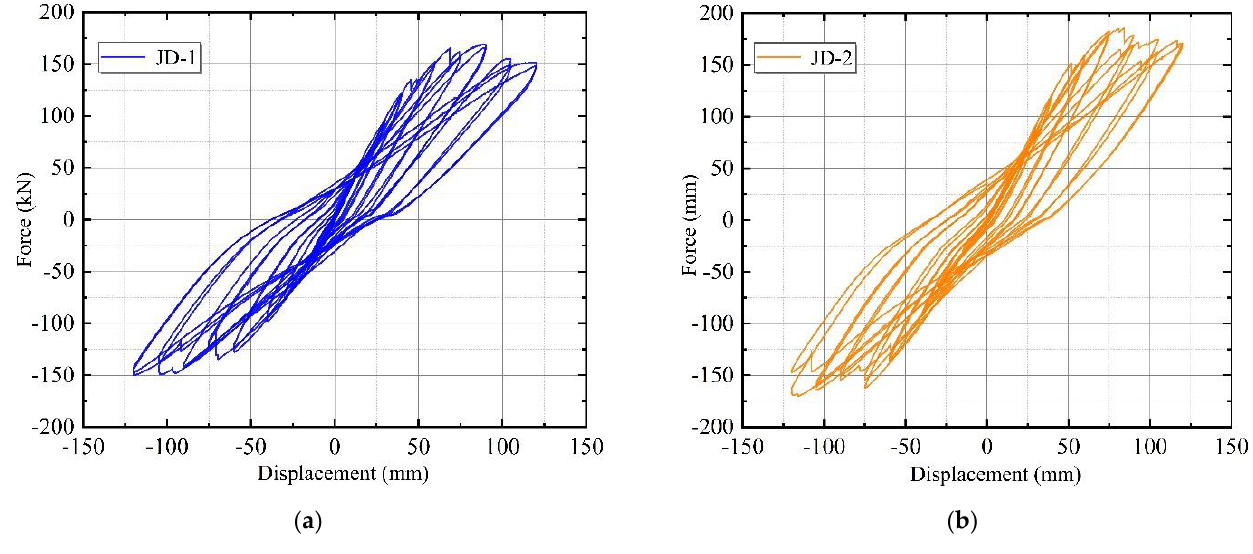
Figure 8. Load – displacement hysteric curves. ( a ) JD-1; ( b ) JD-2. Figure 8. Load–displacement hysteric curves. ( a ) JD-1; ( b )